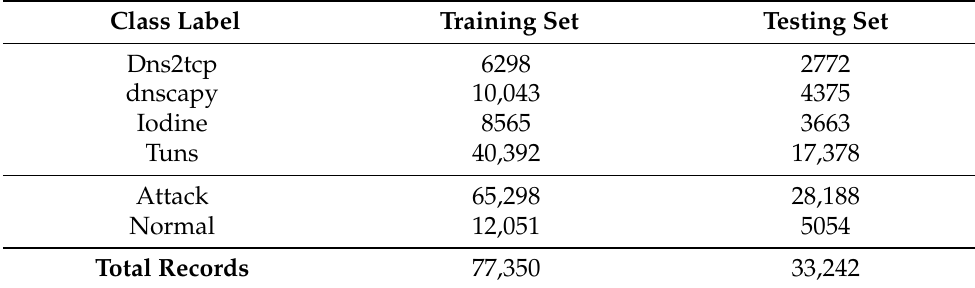
Table 4. # of instances of DNS records from